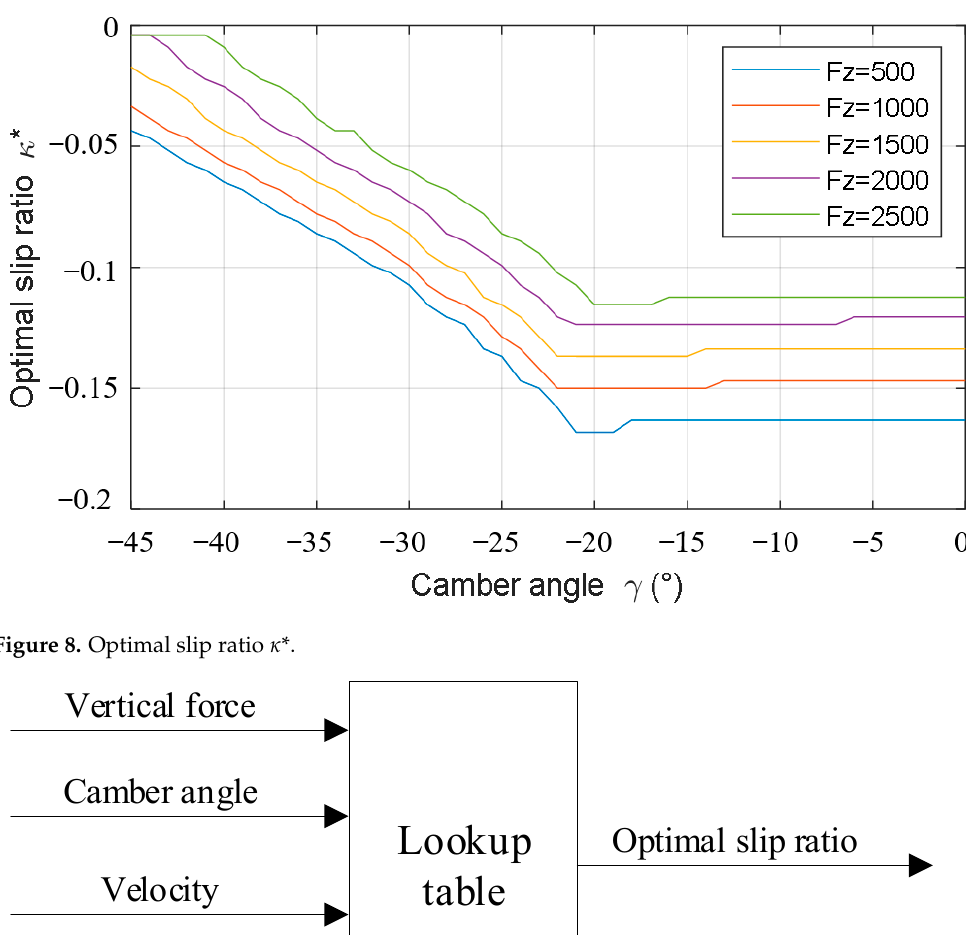
Figure 9. Optimal slip ratio lookup table.